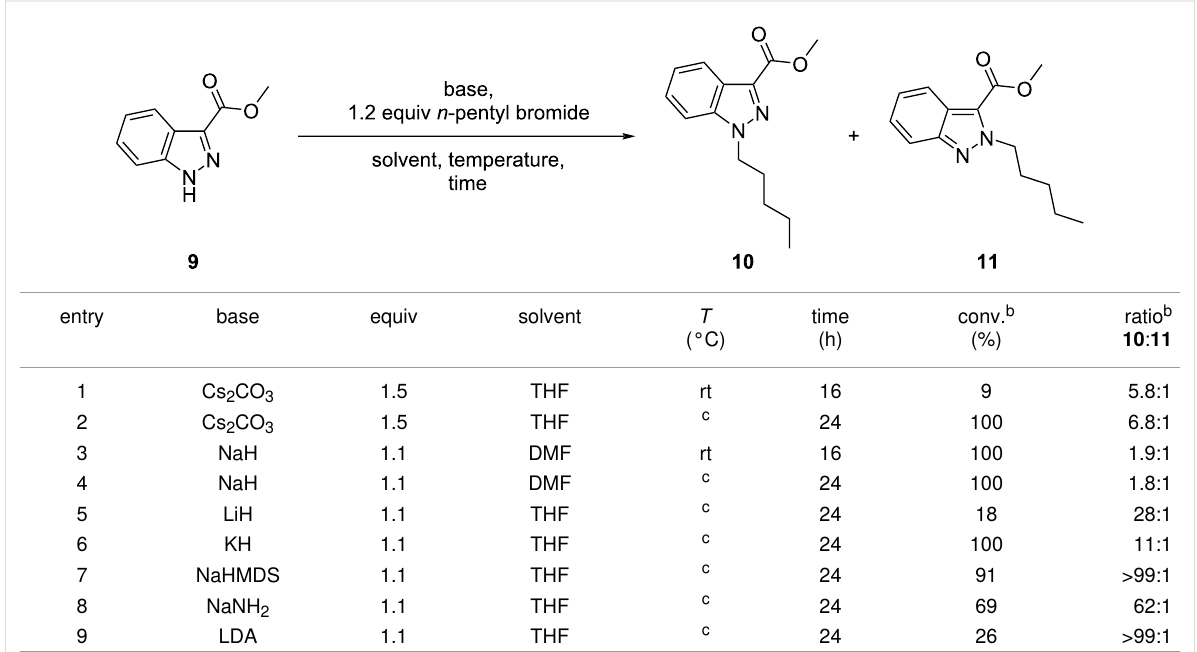
The presence of a nitro or methyl carboxylate group at the C-7 position of the indazole core facilitated excellent N -2 regiose- lectivity under conditions A (Table 4, entries 3 and 4). To further examine the positional effect of benzenoid ring substitu- tion on N -alkylation regioselectivity, 6-, 5-, and 4-CO 2 Me substituted indazole derivatives were alkylated, under condi- tions A and B (Table 4, entries 5–7). While C-4 and C-5 substi- tuted indazole methyl esters showed no apparent N -1 or N -2 regioselectivity under conditions A (ratio N -1: N -2 of both 61 : 62 and 63 : 64 = 1:1.3) (Table 4, entries 6 and 7), the corresponding